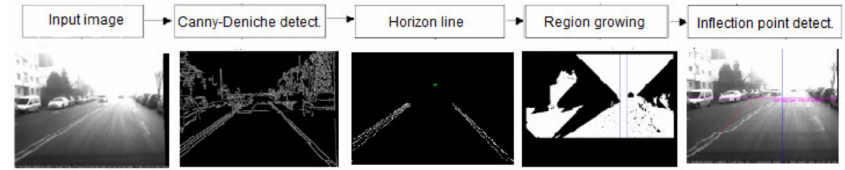
Figure 2. Haze removal method presented in